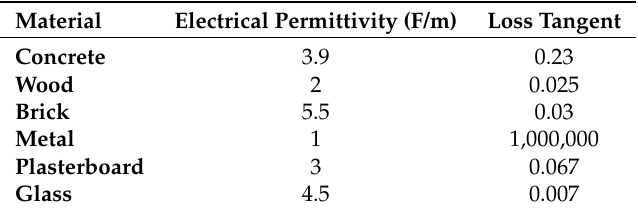
Table 1. Material constitutive parameters of the test